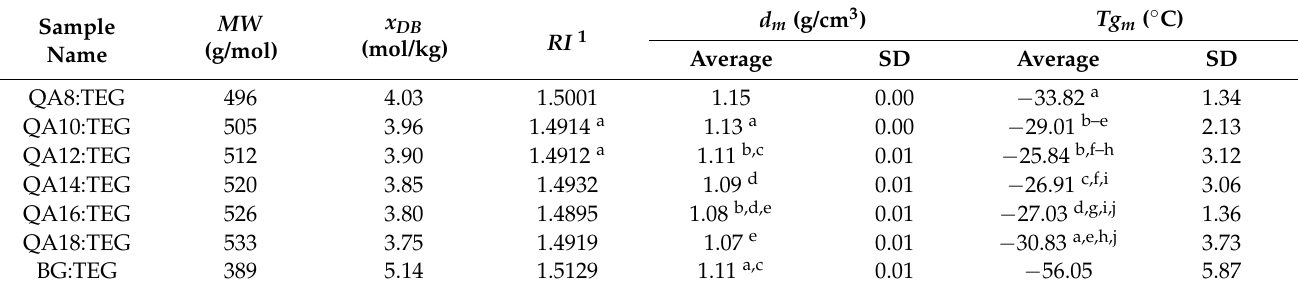
Table 2. Properties of studied liquid monomer compositions: molecular weight ( MW ), the concen- tration of double bonds ( x DB ), refractive index ( RI ), density ( d m ), and glass transition temperature ( Tg m ). Lower case letters indicate statistically insignificant differences ( p > 0.05) with a column (non-parametric Wilcoxon